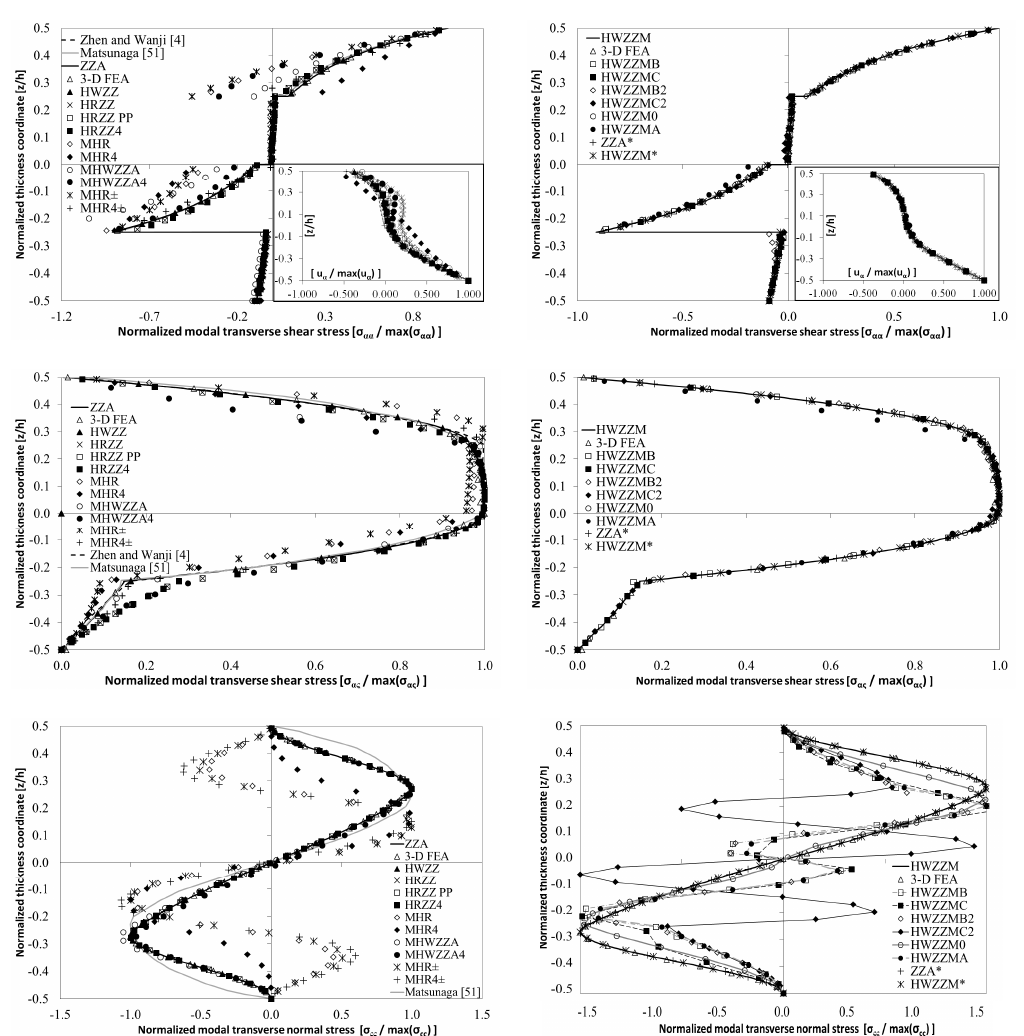
Figure 8. Case c2: Normalized modal displacements and stresses of a simply supported laminated plate ( L x/ h = 10/3).